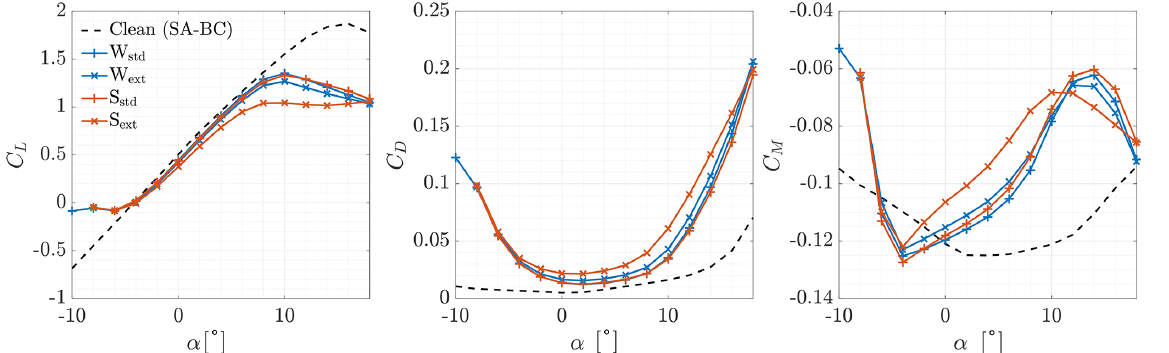
Figure 17. Aerodynamic coefficients of Section A.